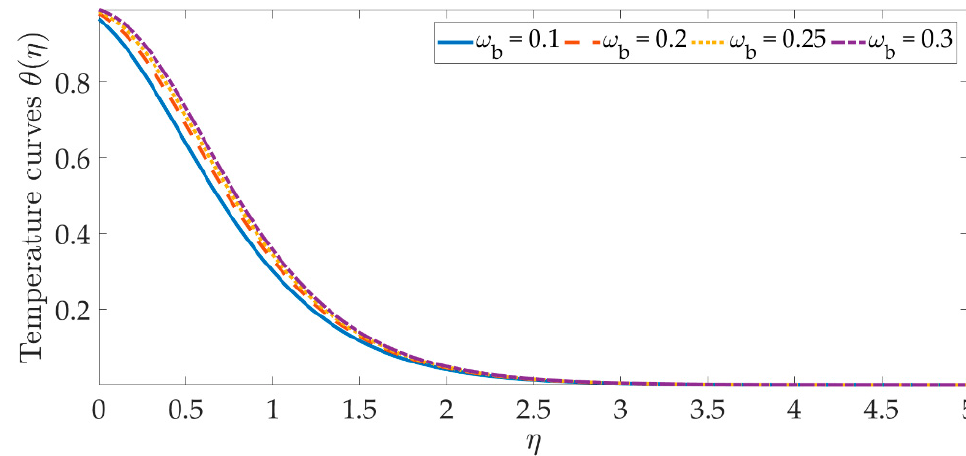
w Figure 10. Temperature curves against the multiple values of ω b .